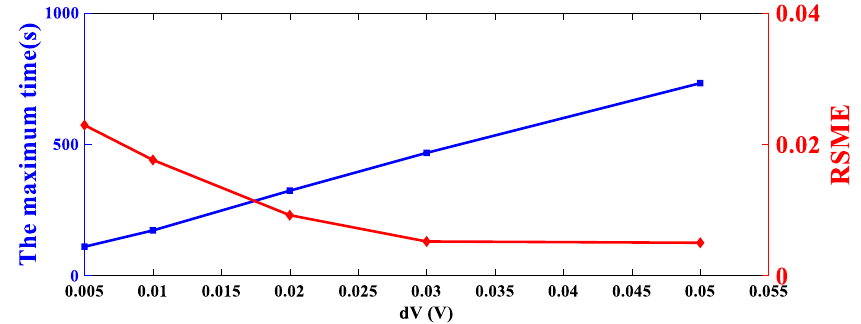
Figure 7. The relationship of RSME of fitting curve, the maximum time to calculate dQ and dV.